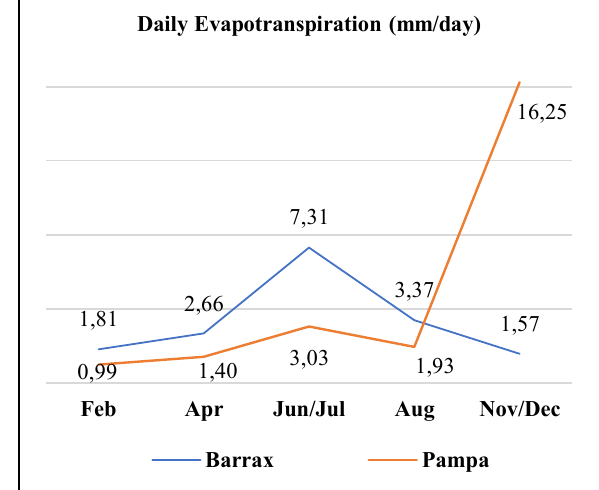
Figure 3. Daily Evapotranspiration for both Pampa Biome and Barrax